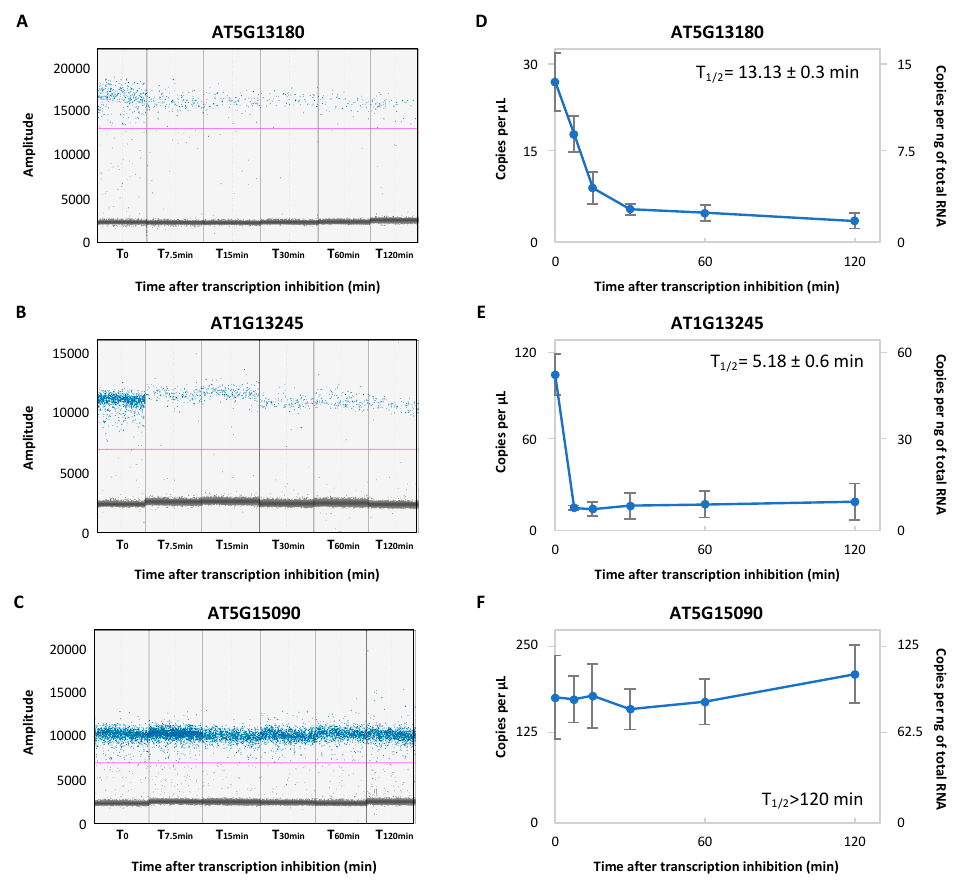
Figure 2. Monitoring mRNA half-life using ddPCR. A ddPCR amplitude plot for AT5G13180 ( A ), AT1G13245 ( B ) and AT5G15090 ( C ) during the transcription inhibition time course. The blue and grey dots correspond, respectively, to the positive and negative droplets. The pink lines correspond to the threshold; and were manually applied, respectively, at 13 000, 7 000 and 7 000 to AT5G13180, AT1G13245 and AT5G15090. D – F . The number of copies per μ L or per ng of the total RNA obtained in A, B and C, respectively. N = 3 biological replicates. Mean ± SD.